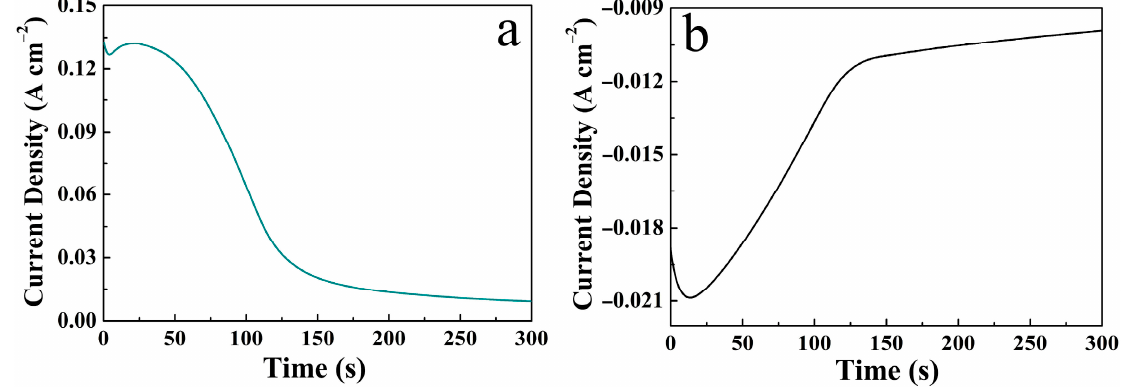
Figure 2. Two-step potentiostatic deposition curves of the CuO/NCS electrode: ( a ) Cu(OH) 2 de- posited onto the CF substrate; ( b ) NCS deposited onto the CuO surface.